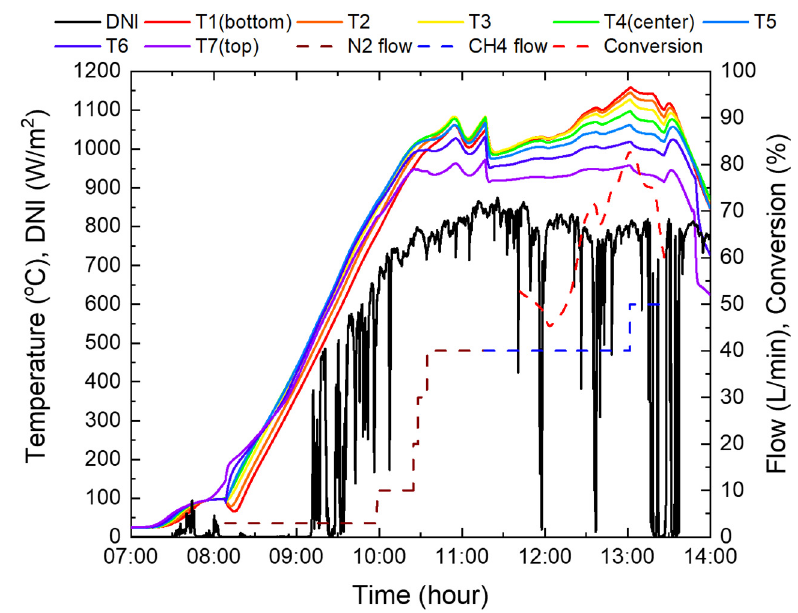
Figure 16. Experimental results using the reactor 3.